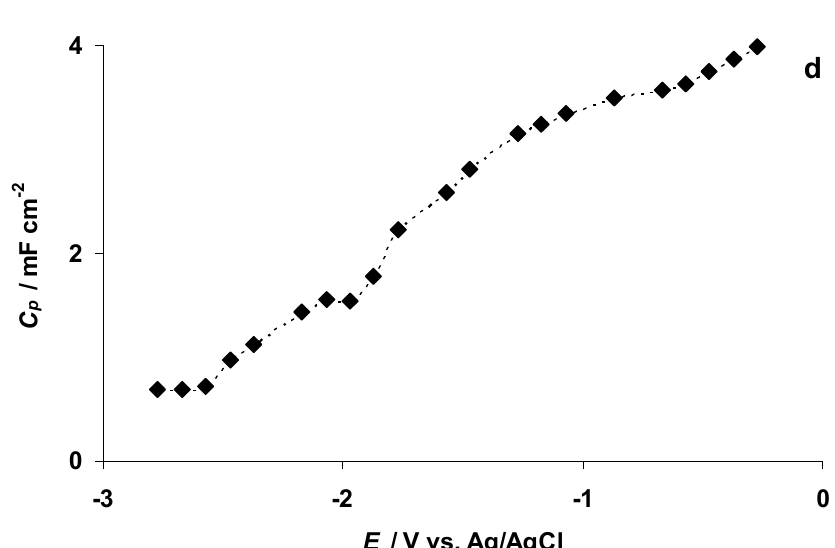
Figure 9. Illustrative data obtained from electrochemical impedance spectroscopy measurements: ( a ) series resistance ( R s ); ( b ) high frequency semicircle resistance ( R HFS ); ( c ) series capacitance ( C s ) (calculated at EIS modulation frequency ( ν ) ν = 0.1 Hz); ( d ) parallel capacitance ( C p ) (calculated at ν = 0.1 Hz) for different consecutively measured electrochemical impedance spectra at various negative potentials for C(Mo 2 C) in the 5 wt % EMImBr solution in EMImBF 4 .